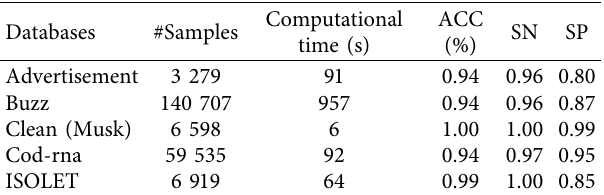
Table 3: Performance measures and computational time of da- tabases using multilevel frameworks. Databases